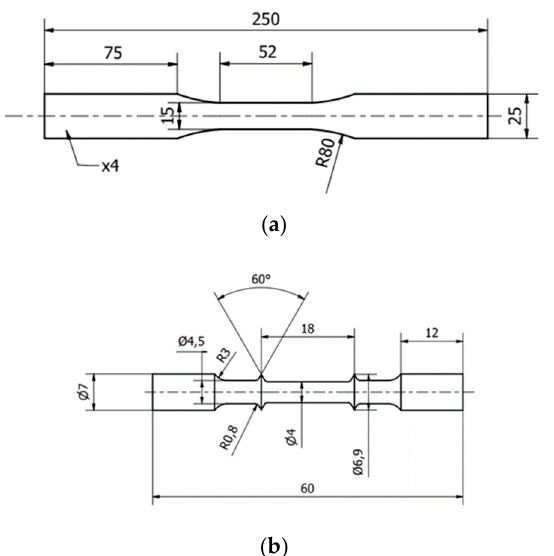
Figure 1. Geometry of the specimen used for: ( a ) uniaxial, standard and high temperature fatigue tests; ( b ) creep tests.